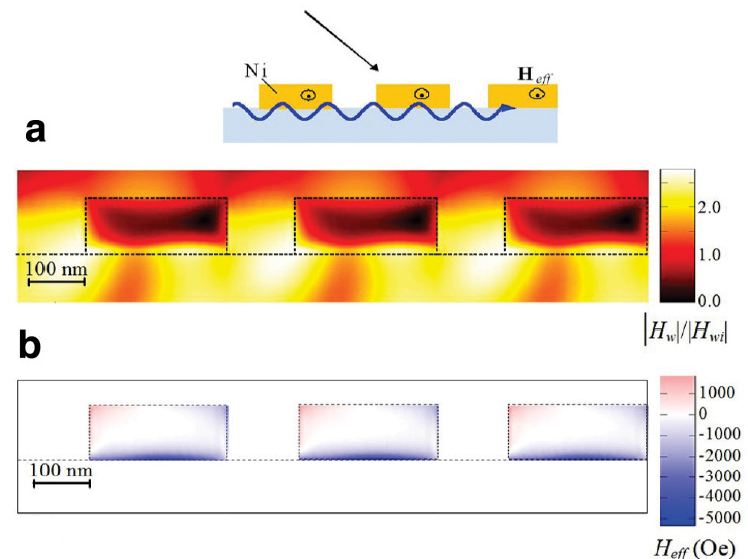
Figure 13. ( a ) Near-field distribution of the absolute value of the electromagnetic wave | in the plasmonic crystal (shown in the inset above) normalised to the magnetic field | H w | ; ( b ) Distribution of the effective magnetic field magnetic field of the incident light | H wi H generated in the plasmonic crystal by the laser pulse. Three periods of the structure eff are shown. A laser pulse with a peak intensity of 500 W/ µ m 2 is p -polarised and is obliquely incident at 10 o . Period d = 400 nm, slit width is 120 nm, and nickel film thickness is 100 nm. Reproduced from [133] with permission by American Physical Society, Copyright